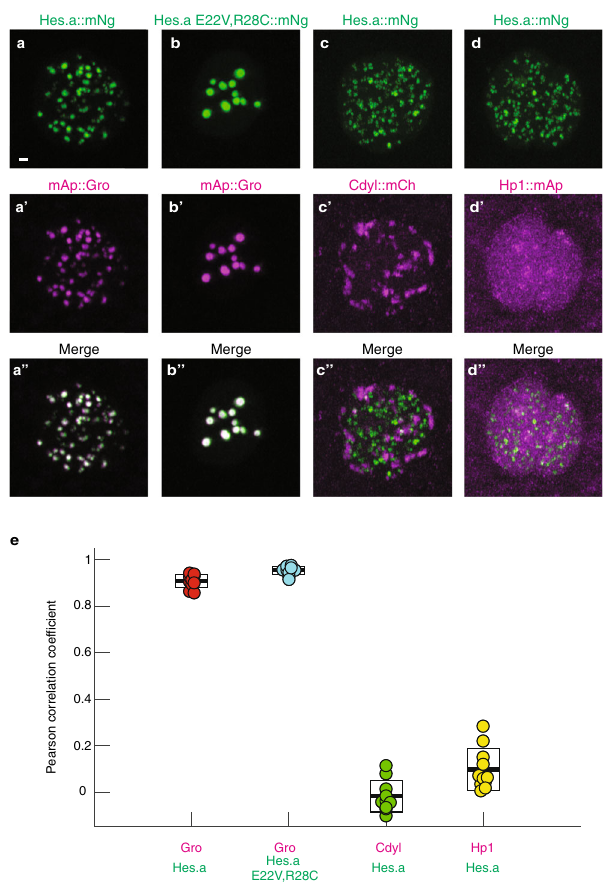
Fig. 4 Hes.a/Groucho puncta are distinct molecular condensates. a Maximum intensity projection confocal images of single Ciona nuclei expressing Hes.a::mNg. a ’ mAp::Gro Fluorescence. a ” The merged green and red channels for a and a ’ . Scale bar = 1 μ m. b – b ” , As for the a series but for Hes.a E22V,R28C::mNG and mAp::Gro Green and red channels are shown individually and merged. c – c ” , Hes.a::mNg and Cdyl:mCh d-d ” , Hes. a::mNg and Hp1::mAp. c Pearson correlation coef fi cients of the experiments shown in a – d ” . Boxes display the mean as the central line and the limits of the box denote standard deviations. All transgenes were expressed using pSP Sox1/2/3 > plasmids. All images are representative of >3 biological replicates. Source data are provided as a Source Data fi